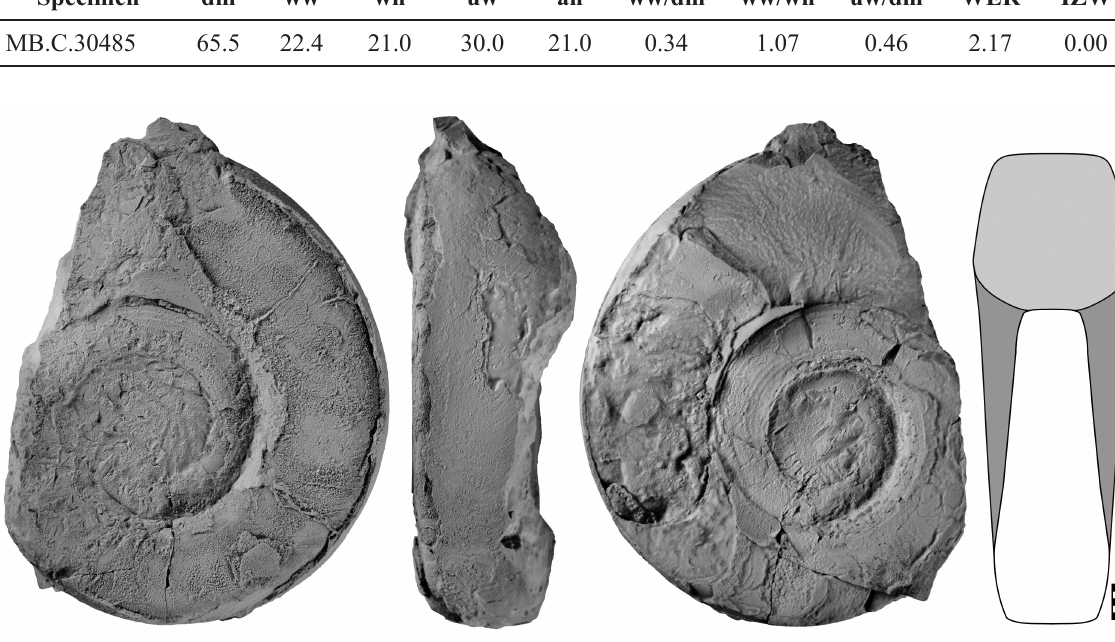
Fig. 28. Maccoyoceras habadraense sp. nov., holotype MB.C.30485 (Korn et al . 2002 Coll.) from Hassi Habadra. Scale bar units = 1 mm.